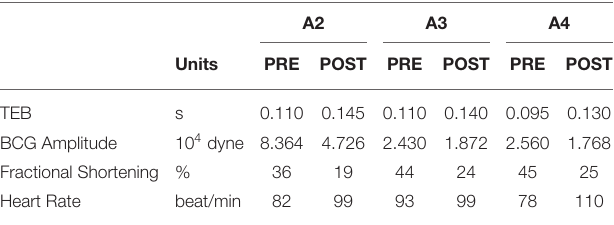
TABLE 2 | Summary of the median values of TEB and BCG amplitude pre- and post-MI, along with the fractional shortening percent determined by echocardiography and the heart rate determined via electrocardiography for Subjects A2, A3, and